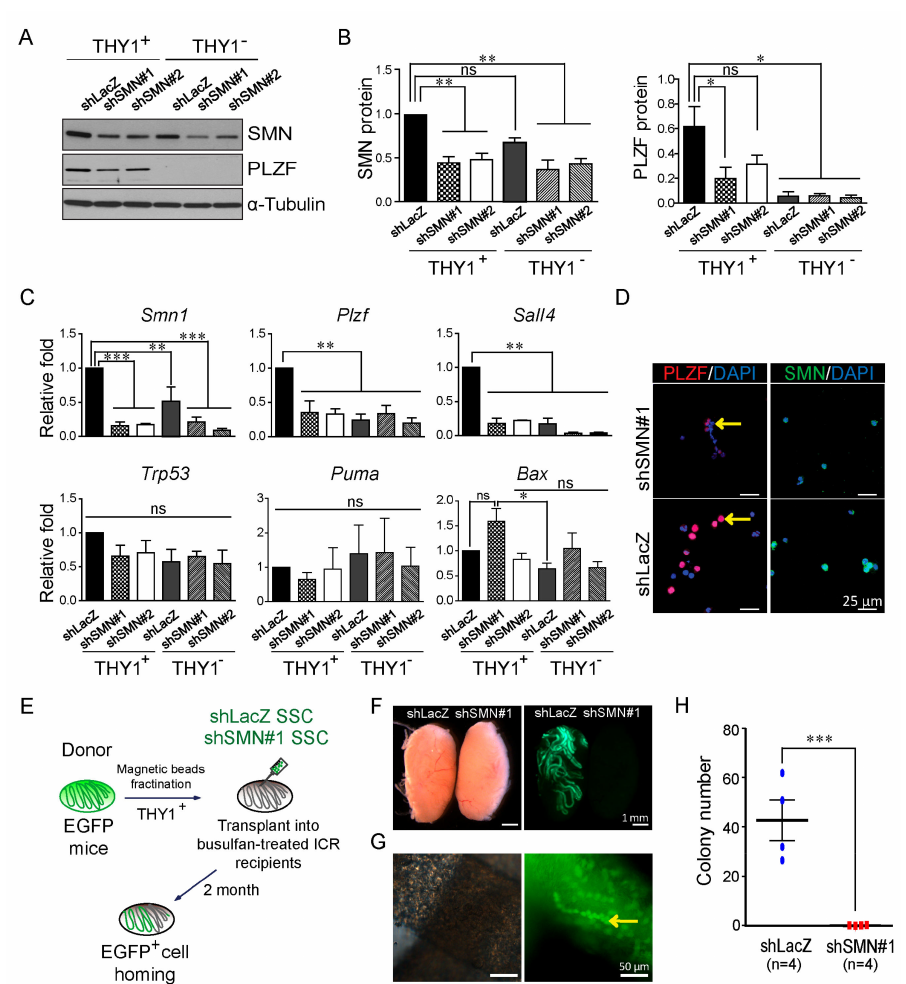
Figure 3. Spermatogonial stem cells (SSCs) show decreased PLZF expression and lost the ability of self-renewal after SMN knockdown. (A) Western blot analysis and its quantification (B) demonstrated decreased PLZF protein following lentiviral shSMN transduction in SSCs enriched by MACS isolated from 6–7 days postpartum (dpp) testes of C57BL / 6JNarl mice (shSMN#1 and shSMN#2). Compared with the control shLacZ group, a significant di ff erence is shown. α -Tubulin is used as the internal control of the Western blot. The original Western blot is shown in Supplementary Figure S4 ( n = 2). (C) Real-time PCR analysis of SMN-depleted SSCs. Smn1 , spermatogonia makers, Plzf and Sall4, and apoptotic markers Trp53, Puma, and Bax were analyzed ( n = 3). (D) Immunofluorescent staining demonstrates SSCs express less PLZF in the SMN knockdown group (shSMN#1, red color, arrow indicated) compared to the control shLacZ group. 4 (cid:48) ,6-diamidino-2-phenylindole (DAPI) is used as the counterstain (blue). (E) Schematic illustration of the process of SSC transplantation. (F) SSCs carrying enhanced green fluorescent protein (EGFP) transplanted into a recipient testis shows colonization in the shLacZ group (left testis) but not in SMN-depleted SSCs (shSMN#1, right testis). (G) Aligned EGFP-positive cells in the shLacZ control group represent the homing ability and normal proliferation (arrow). (H) Quantification of the SSC homing e ffi ciency. Each spot indicates one replicate of the transplanted mouse. *Indicates significance, p < 0.05; **, p < 0.005; ***, p < 0.001; ns indicates no